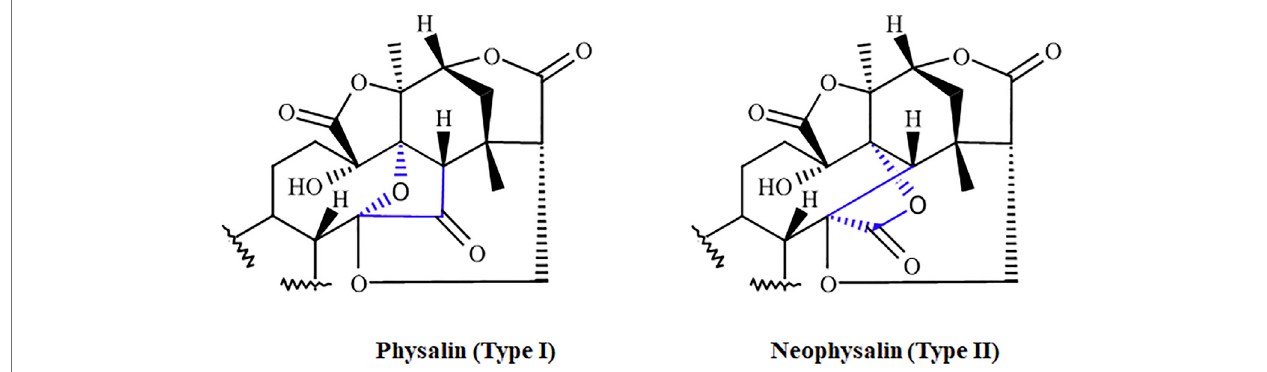
FIGURE1| Thetwosubclassesofphysalins.Physalins(TypeI),inwhichC-14islinkedtoC-17throughoxygentoformanacetalbridge,andneophysalins(TypeII), in which C-14 is linked to C-16, while esterization of C-15/C-17 forms a lactone. The main differences between the two types are highlighted in blue.